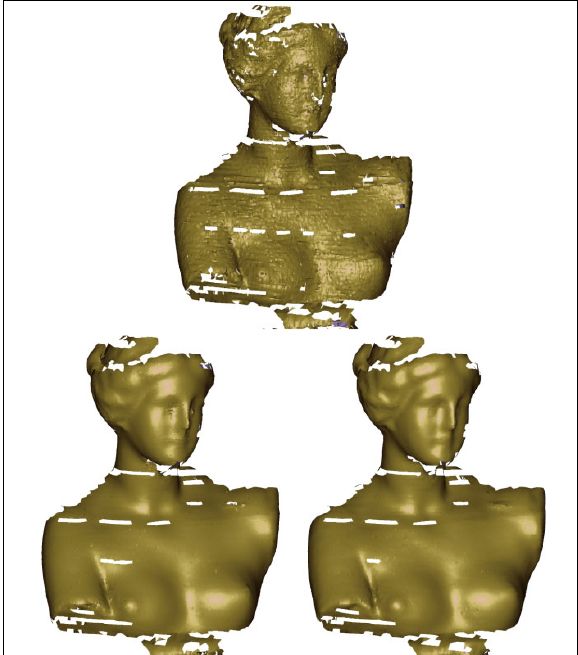
Figure 9. Initial point cloud (above); smoothing using the plane fitting (left) and using fitting of elliptic paraboloids